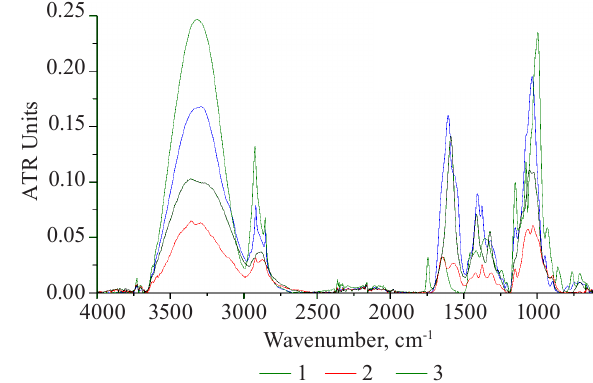
Figure 2 IR-spectra of dry samples of plant and animal polysaccharides: (1) hyaluronic acid, (2) insoluble starch, (3) fibrous cellulose, (4)